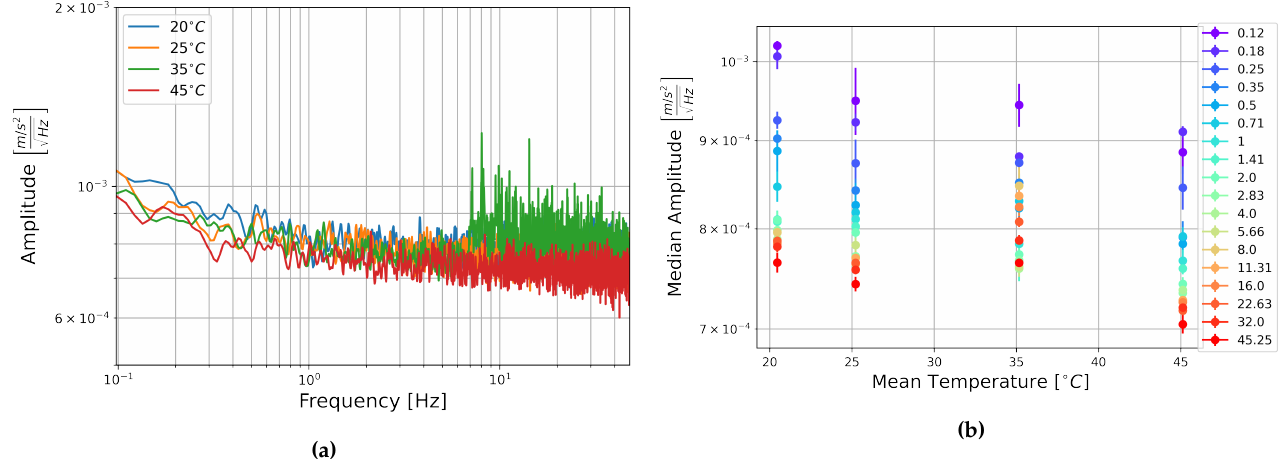
Figure 15. ( a ) Square root of the PSD of component HNZ at each temperature step and ( b ) Median amplitude of the PSD per half-octave as a function of temperature. Vertical error bars show standard deviation of amplitudes, and horizontal bars show standard deviation of temperature measurements.